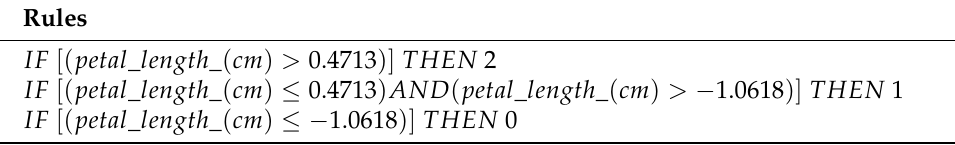
Table A18. Final rule set for the Iris dataset generated by DEXiRE.